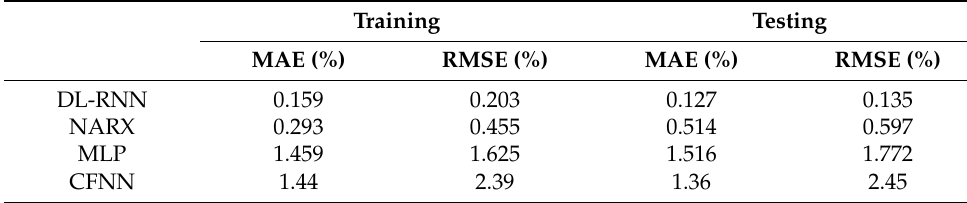
Table 6. Performance comparison of different methods (Challenge dataset).